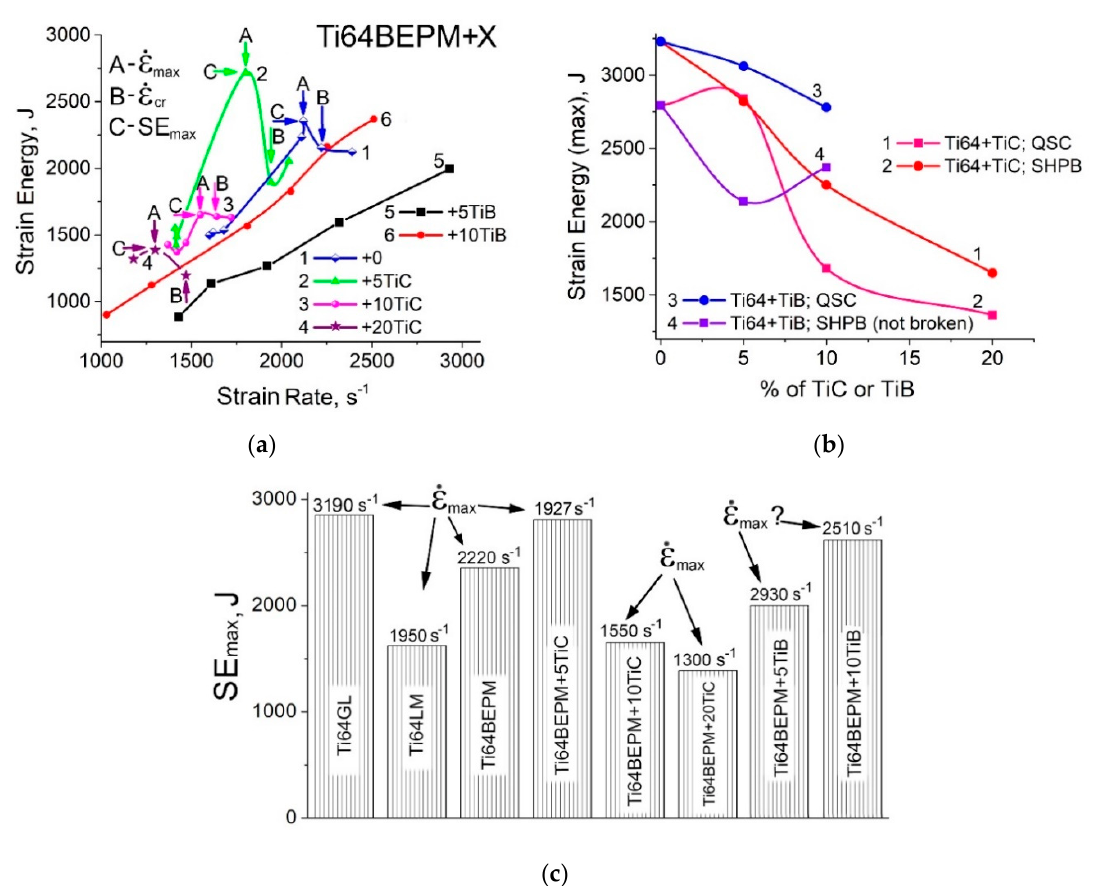
Figure 6. The strain energy SE : ( a ) vs. strain rate dependencies for studied Ti64BEPM based materials without (1) and MMCs with (2–4) TiC, and (5,6) TiB particles; ( b ) The strain energy SE for QSC with rate 10 − 3 s − 1 and high-strain-rates SHPB compressions vs. content of TiC or TiB particles; ( c ) the SE max and ε max values for tested materials compared with the data for Ti64GL and Ti64LM taken from [22]. Vertical arrows in ( a ) indicates the strain rates at which specimens fracture. A, B, and C in ( a ) indicate measured values of ε max , ε cr , and SE max respectively. The “?” sign in ( c ) above the Ti64BEPM + 10TiB bar means that it is not known whether this value is the limit, since the sample was not broken and it was not tested at a higher strain rate.